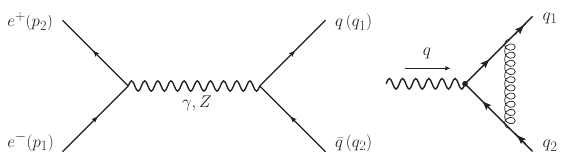
Figure 1: Feynman diagrams for the partonic process e + e − → QQ at LO and